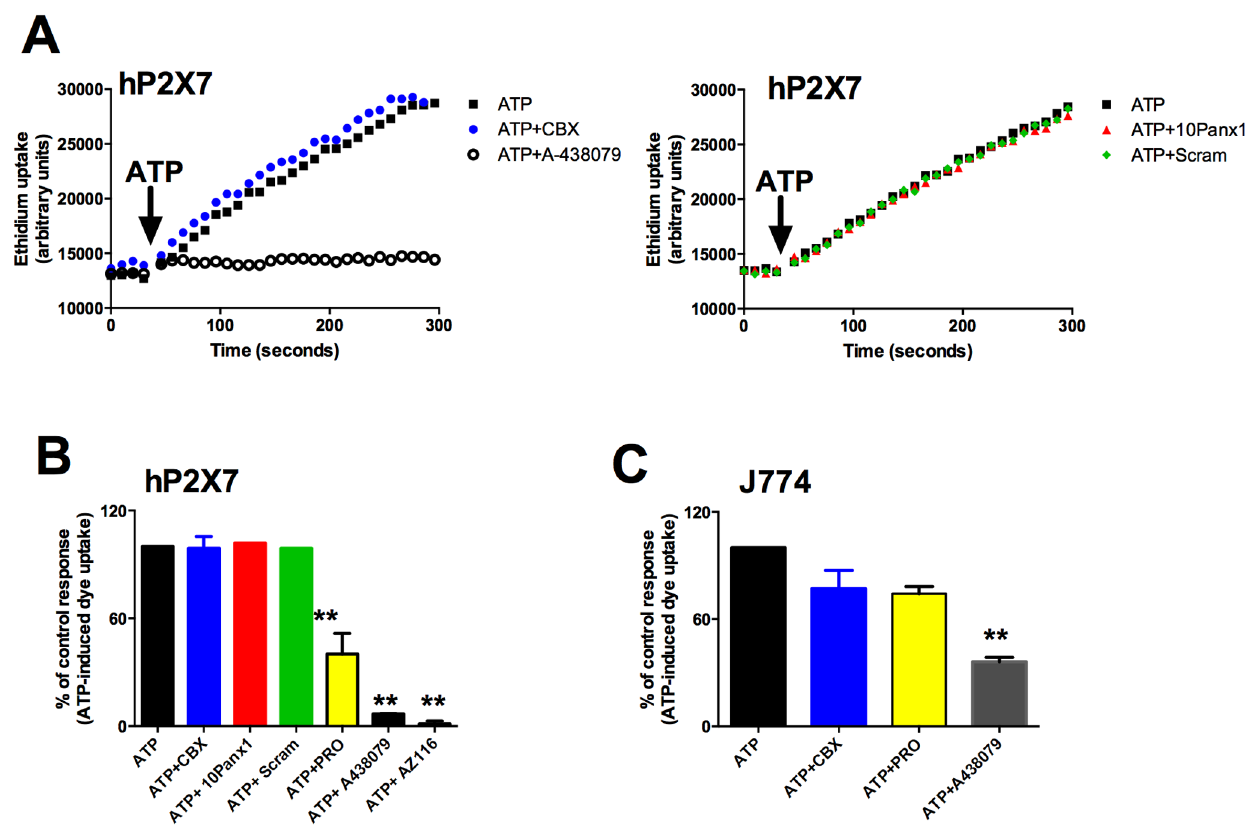
Figure 1. Effect of pannexin-1 inhibitors on ATP-induced dye uptake in HEK-293 cells expressing human P2X7 and J774 macrophages. (A) Ethidium + uptake was induced in HEK-hP2X7 expressing cells by the addition of 1 mM ATP (denoted by the arrow) in low divalent physiological solution. Control ethidium uptake to ATP is shown in black squares. Cells were pre-incubated with inhibitors for 10 minutes at 37 u C before ATP addition. In the top panel ethidium uptake in the presence of 10 m M carbenoxolone (CBX) is shown in blue circles and in the presence of 10 m M A438079 in black open circles. In the lower panel ethidium uptakes in the presence of the pannexin-1 peptide ( 10 Panx1) or scrambled 10 Panx1 peptide are shown in red triangles or green diamonds respectively. Cellular fluorescence was measured using a fluorescent plate reader over 300 seconds. (B) Bar chart displaying mean data from 2–5 separate experiments using inhibitors carbenoxolone (CBX), 10 Panx1 peptide or scrambled 10 panx1 peptide (100 m M), A-438079 and AZ11645373. Data was calculated at 300 second timepoint as baseline corrected endpoint data and normalised to the ATP control. (C) ATP (3.4 mM) induced ethidium uptake was measured in J774 macrophages. CBX (50 m M), PRO (2.5 mM) and A438079 (10 m M) significantly reduced the response. Error bars represent S.E.M, ** P , 0.05 calculated by one-way ANOVA (Dunnett’s post-test).